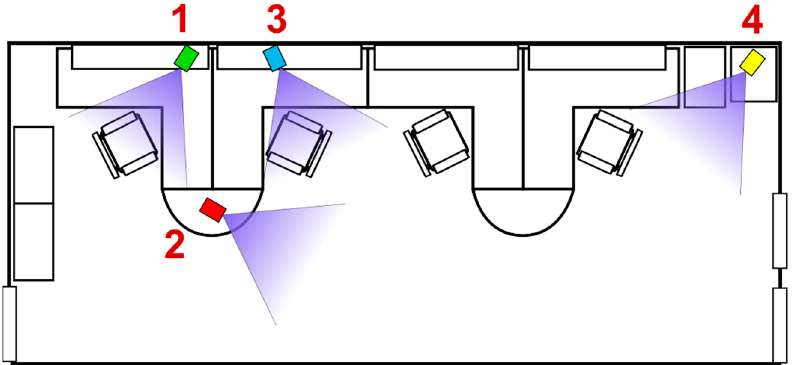
Figure 14. Depth sensor locations blueprint for testing and training inside an office, each number indicates where the depth sensor was located. Table 4. Camera/depth sensor location information.